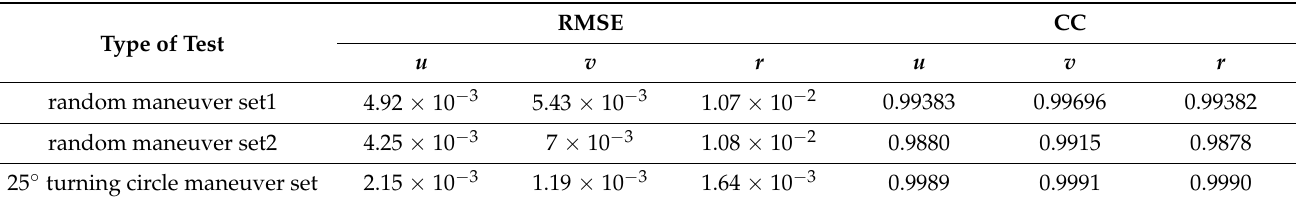
Table 4. Prediction accuracy of the USV